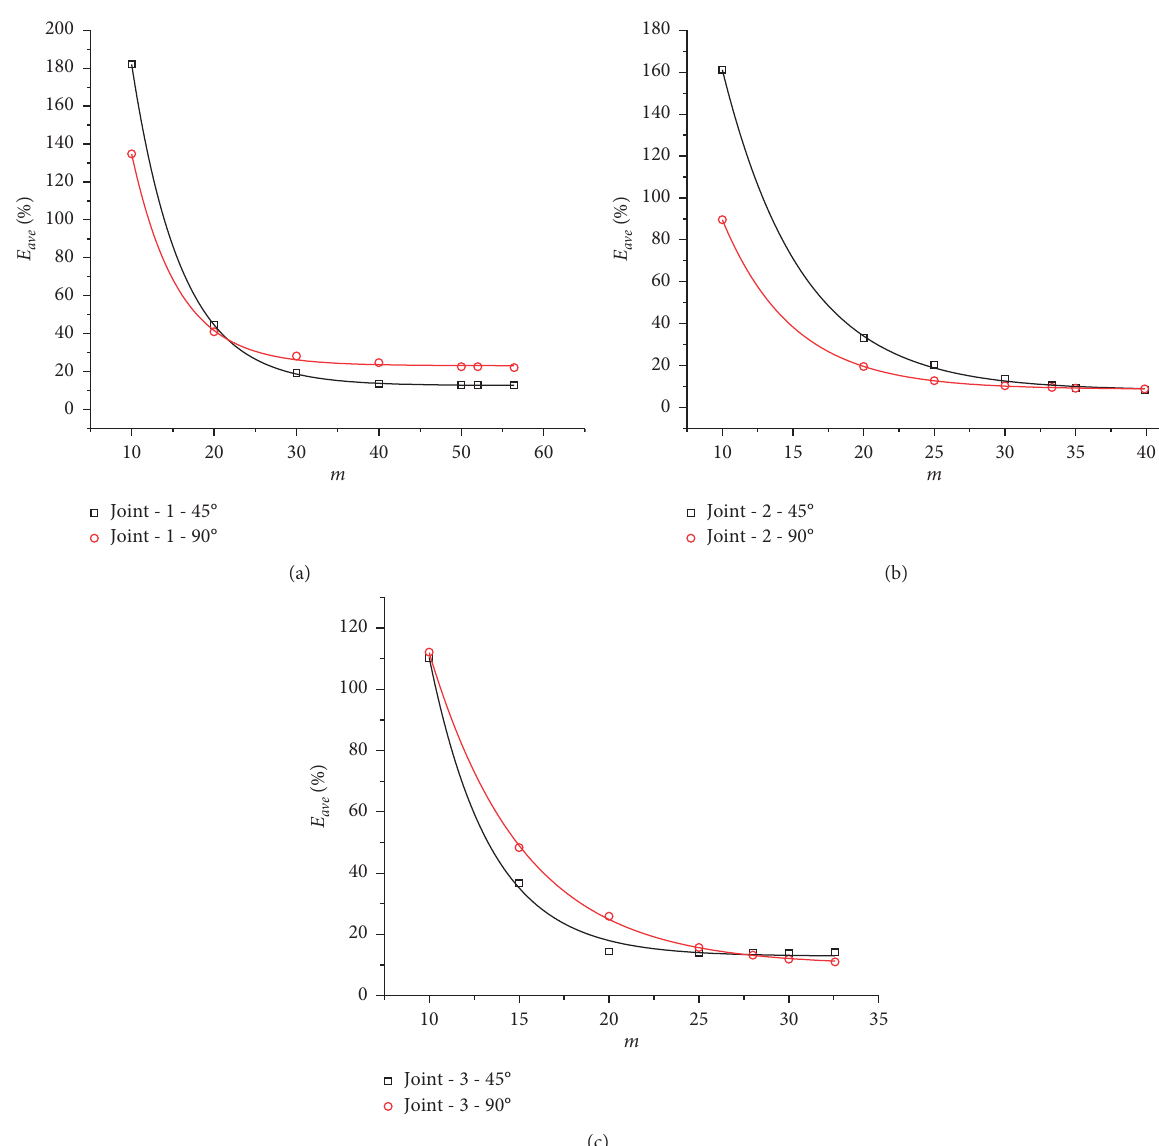
Figure 7: Relationship between E ave and m . (a) Joint with one bolt. (b) Joint with two bolts. (c) Joint with three